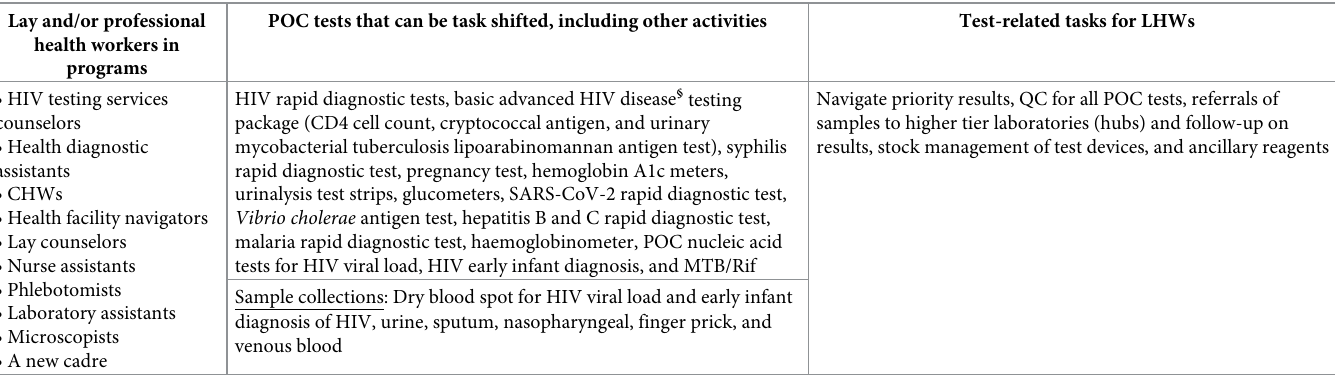
Table 1. Panel with list of potential lay testers, the POC tests they could conduct, and other activities. Lay and/or professional health workers